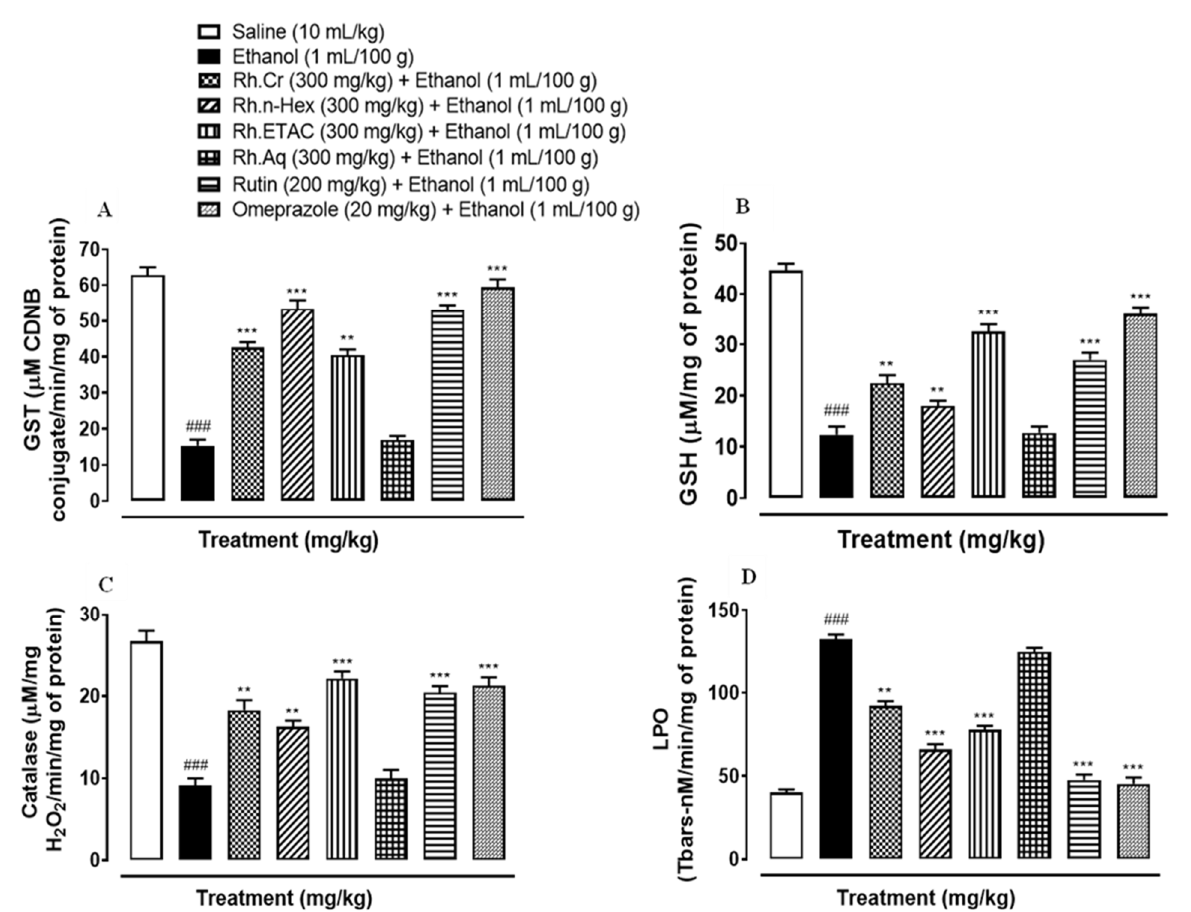
Figure 7. Effect of Rumex hastatus crude extract (Rh.Cr), n-hexane (Rh.n-Hex), ethyl acetate (Rh.ETAC), an aqueous fraction (Rh.Aq), rutin and omeprazole groups against ( A ) glutathione-S-transferase (GST), ( B ) reduced glutathione (GSH), ( C ) catalase and ( D ) lipid peroxidation (LPO) in ethanol-treated rats gastric tissues. Values are expressed as mean ± SEM ( n = 3). One-way ANOVA with post-hoc Tukey’s test. ### p < 0.001 vs . saline group, ** p < 0.01, *** p < 0.001 vs. ethanol group.